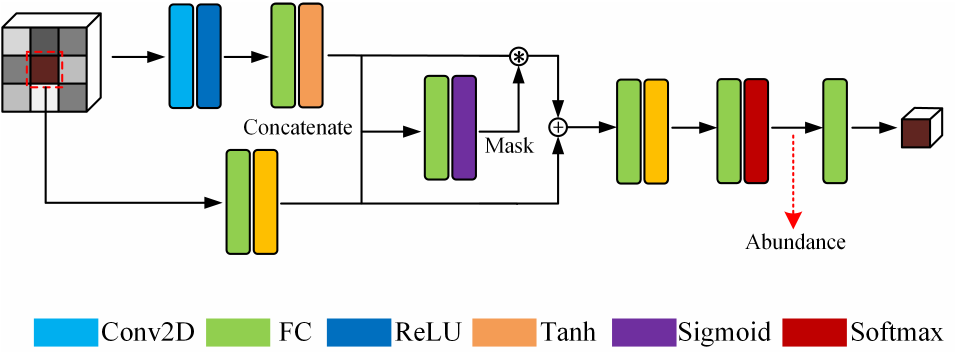
Figure 2. Architecture of gated dual branch autoencoder